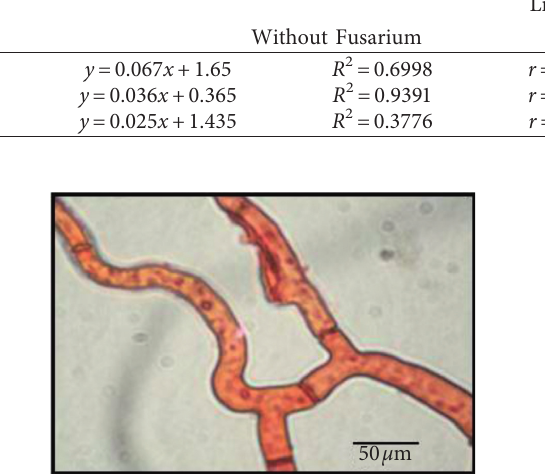
Figure 1: Hyphae binucleate Rhizoctonia (BNR) of the vanilla root under the binocular microscope (50x magnification).